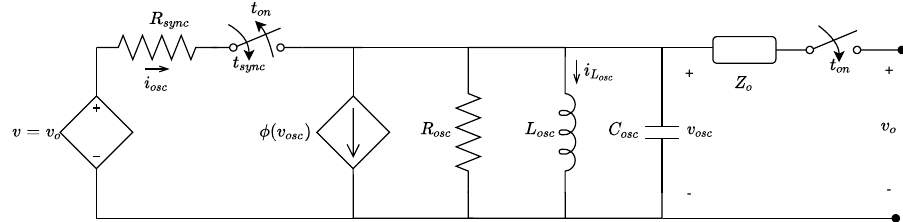
Figure 5. VOC schematic with pre-synchronization